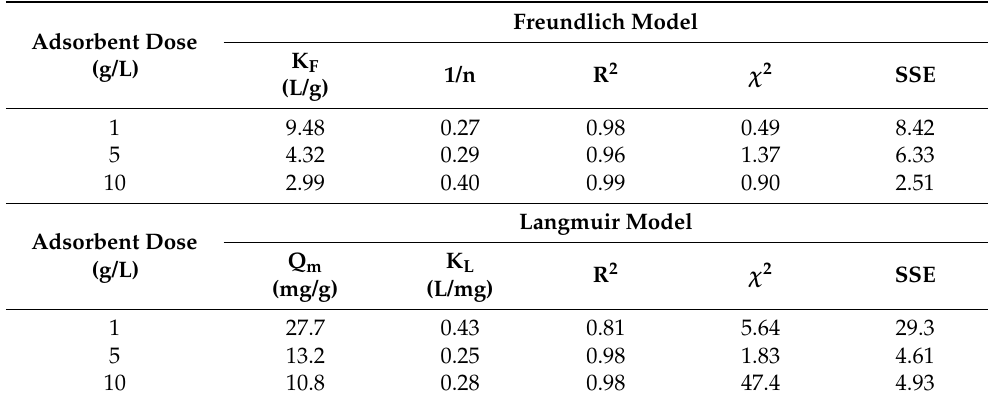
The adsorption kinetics were examined with diverse doses of S.P@Ca-SA for Pb(II) removal at the initial concentration (C 0 = 100 mg/L), and the results are depicted in Figure 8b. S.P@Ca-SA attained equilibrium after 6 h of contact with the Pb(II) solution. order and -second-order models, were fitted, and the error functions for R 2 , χ 2 , and SAE correlation coefficients are enlisted in Table 3. R 2 , χ 2 , and SSE values of the